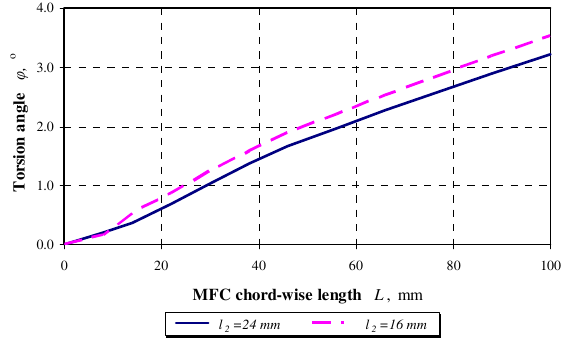
Fig 6. Influence of MFC chord-wise length on torsion angle